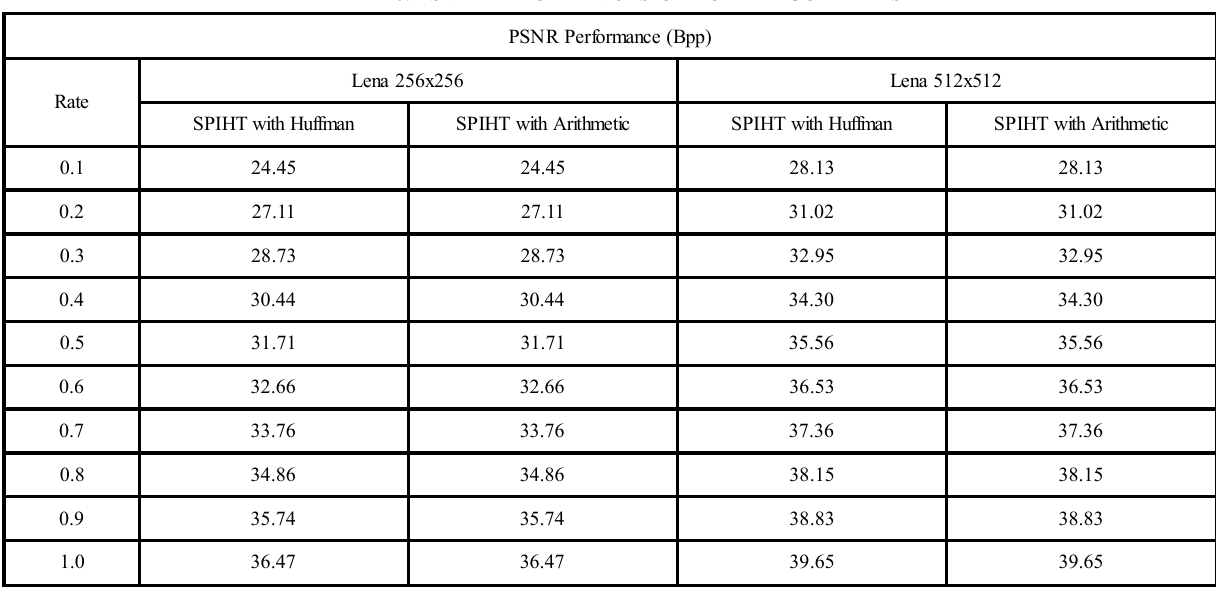
TABLE 6. PSNR PERFORMANCES OF BOTH